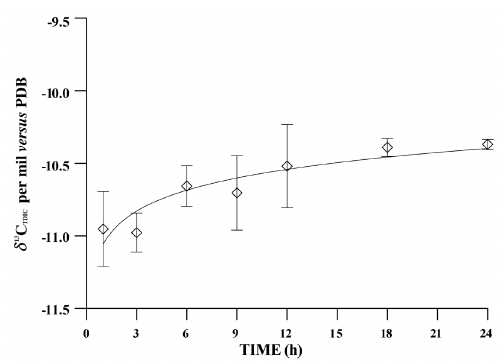
Fig. 3. Evaluation of equilibration times on the Na 2 CO 3 aqueous standard solution with a DIC content of 4 mmol/l. The error bar indicates the standard devi- ation of at least triplicate measurements. After about 18 h the carbon isotope exchange between gaseous CO 2 and carbon dioxide dissolved in the aqueous stan- dard solution can be considered completed reaching an equilibrium value of –10.38 ‰ versus